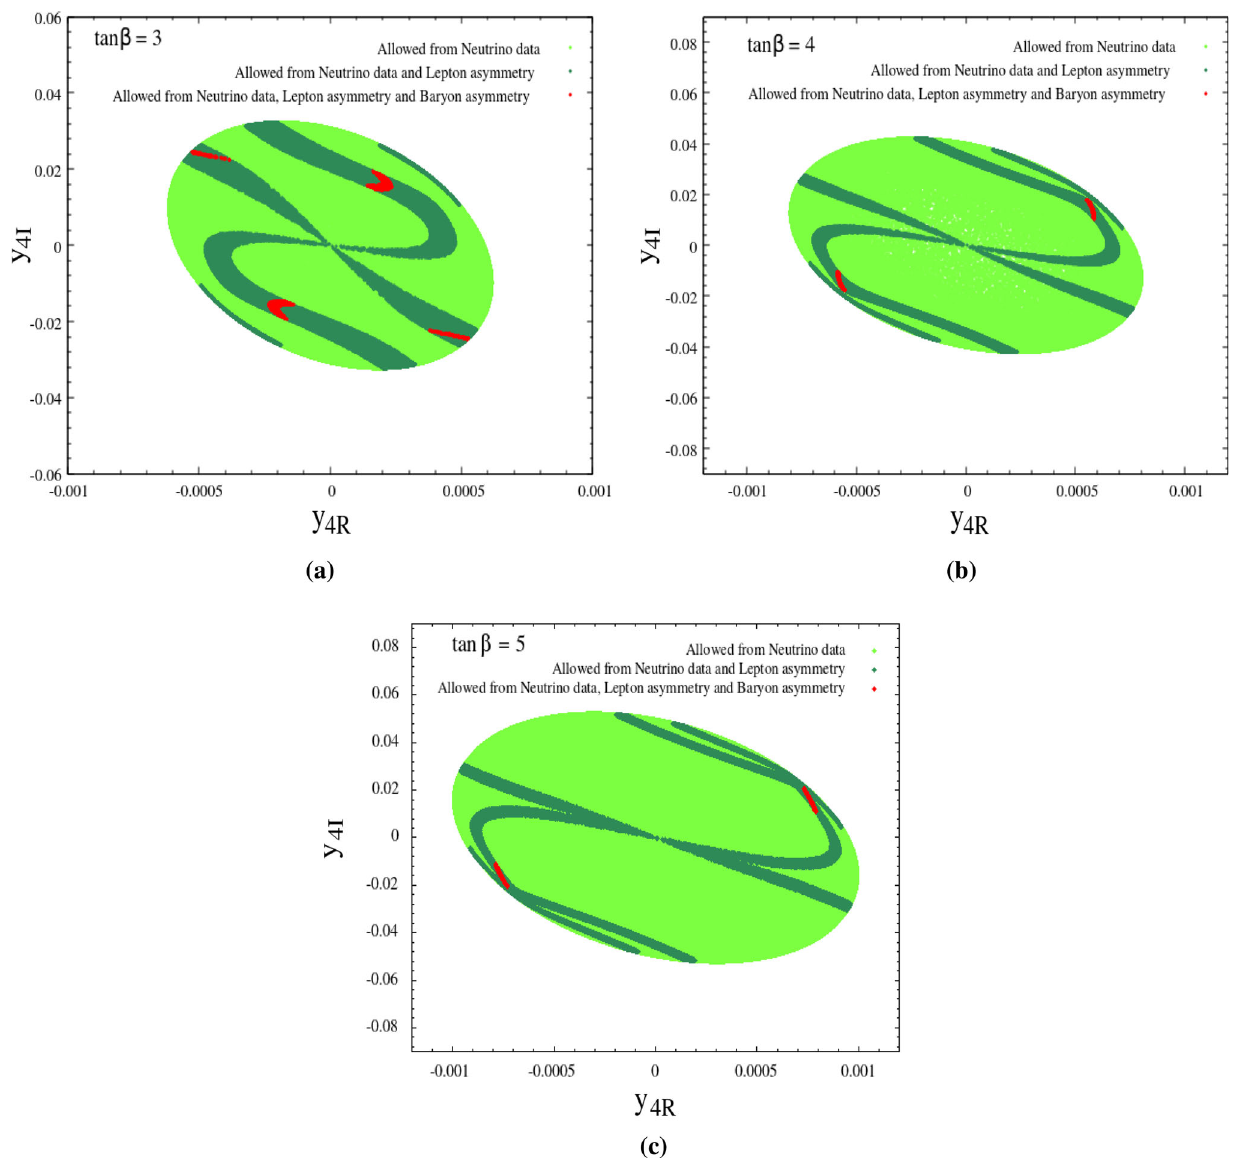
Fig. 8 Parameter space in real vs. imaginary part of Yukawa coupling y 4 . Plots are given for tan β = 3 (upper panel left), tan β = 4 (upper panel right), tan β = 5 (lower panel). Light green, deep green and